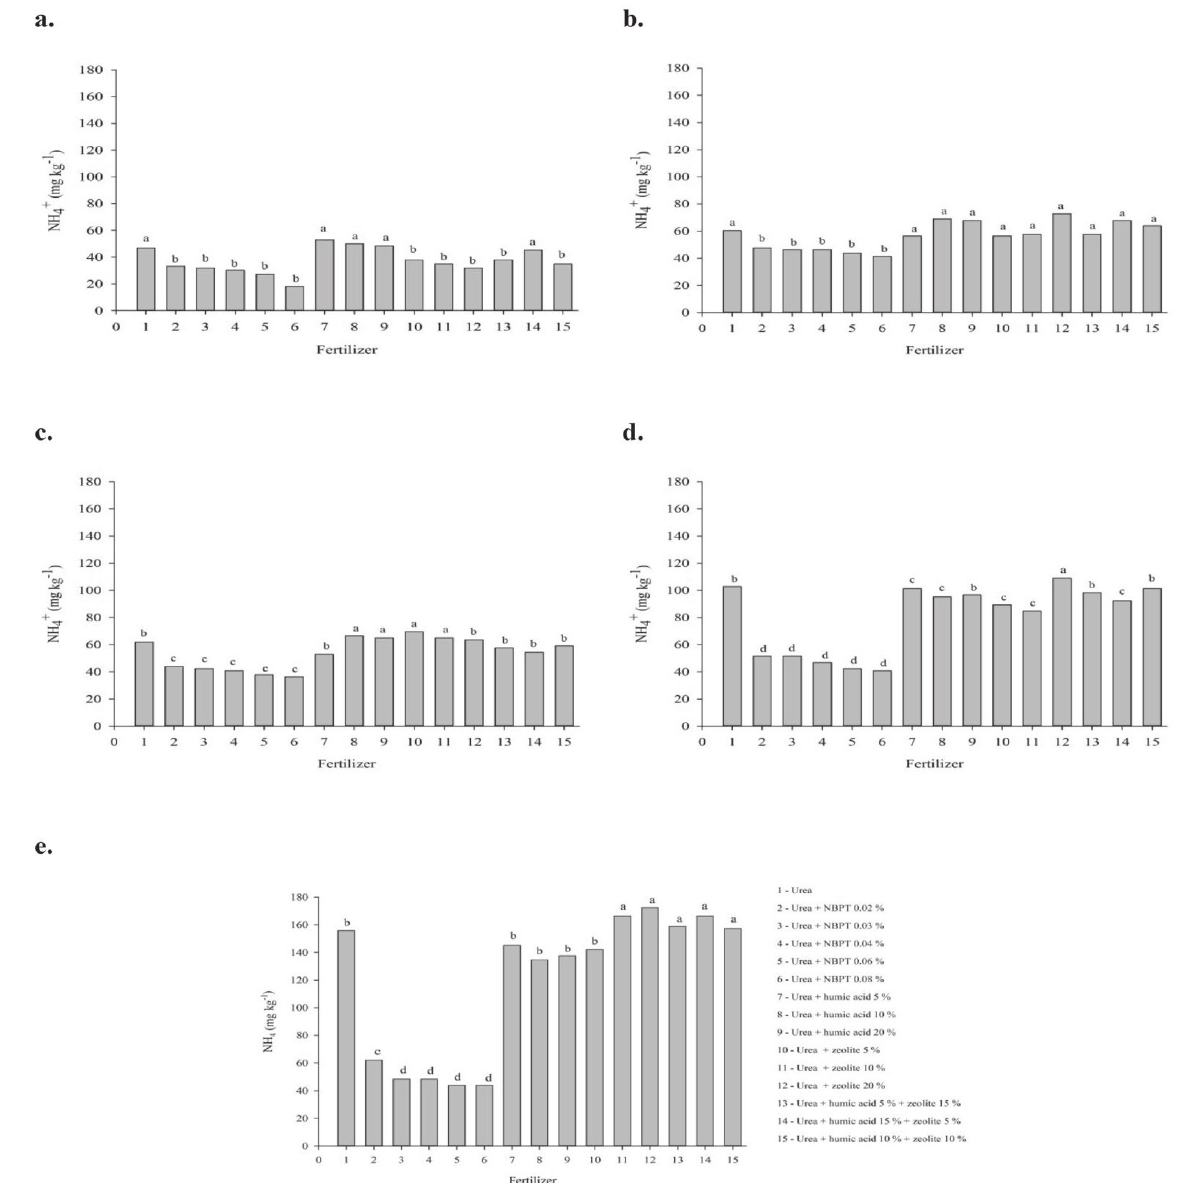
Figure 1 - Ammonium production, due to the hydrolysis of the conventional and additive urea, submitted to ( a. ) - 2, ( b. ) - 4, ( c. ) - 6, ( d. ) - 24 and ( e. ) - 36 hours of incubation. Different letters between the columns indicate difference by the Scott-Knott test at 5%. Analyzes carried out following proposed methodology May and Douglas